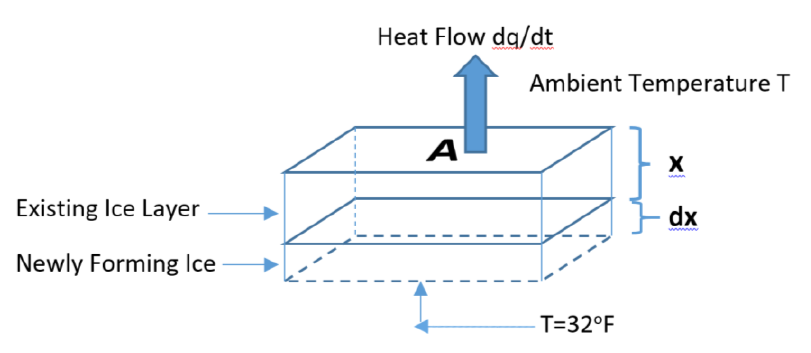
Fig. 13. Schematic of ice freezing at the surface of a